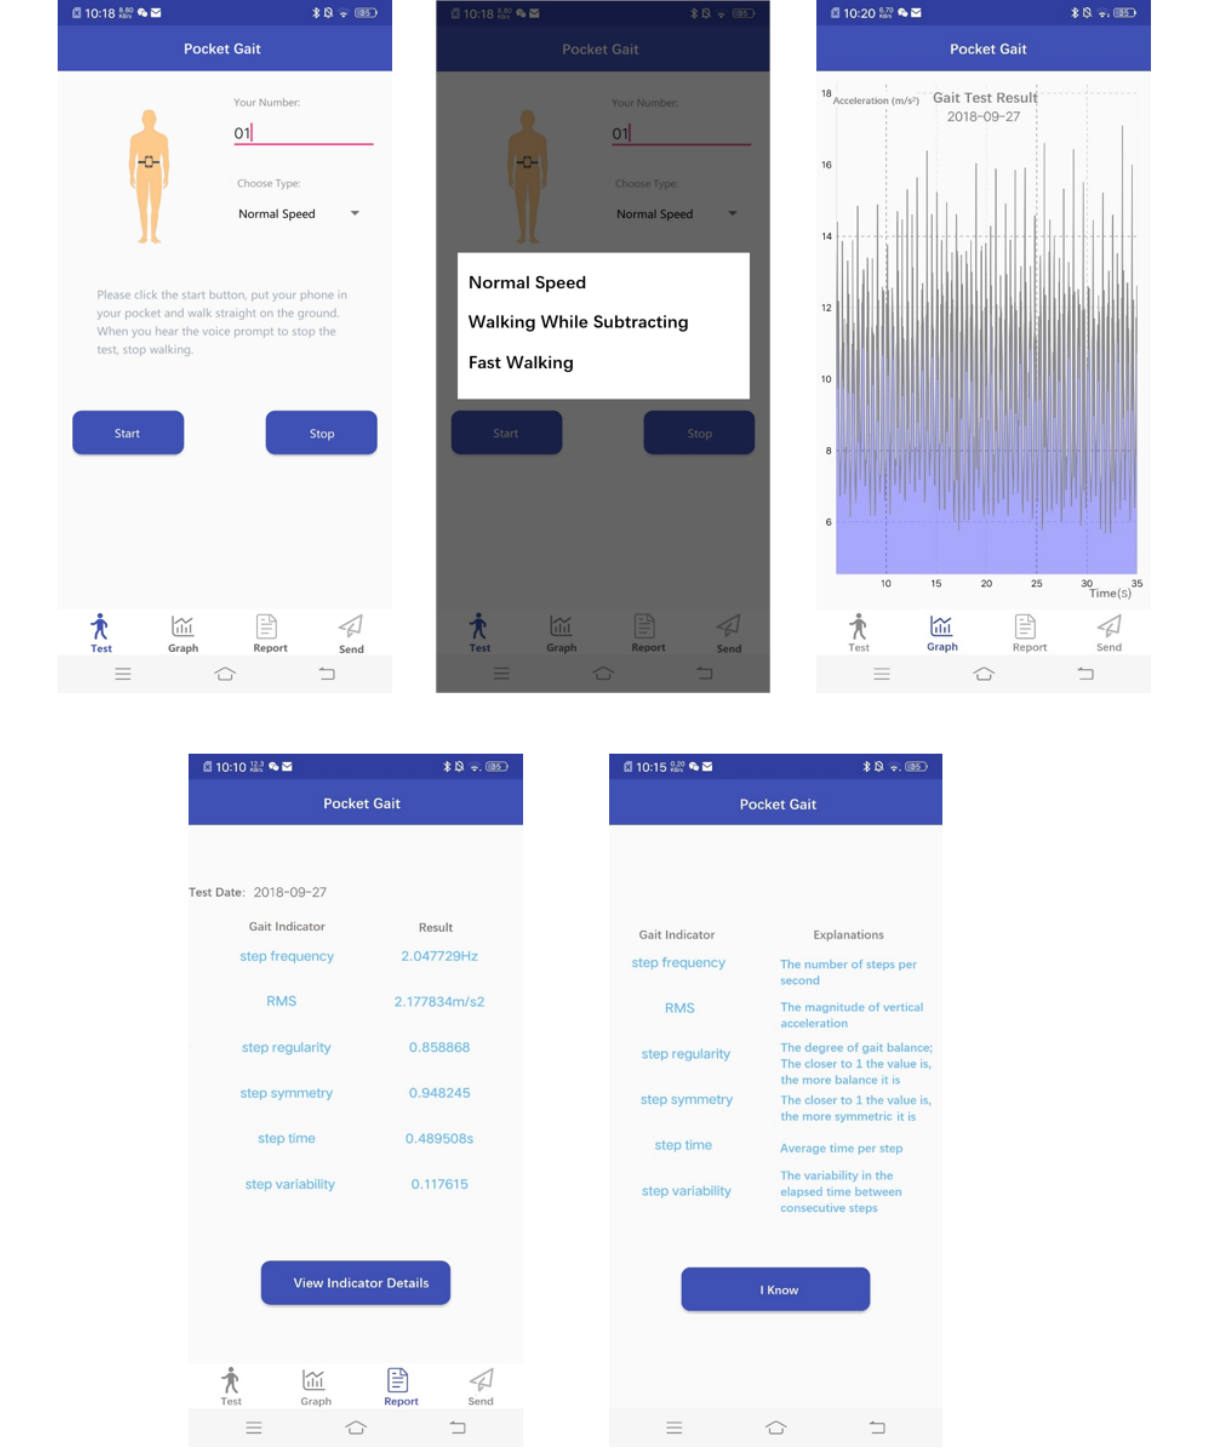
Figure 3. Screenshots of the Pocket Gait app: the gait test page, the choosing walking type page, the viewing graph page, the report page, and the explanation